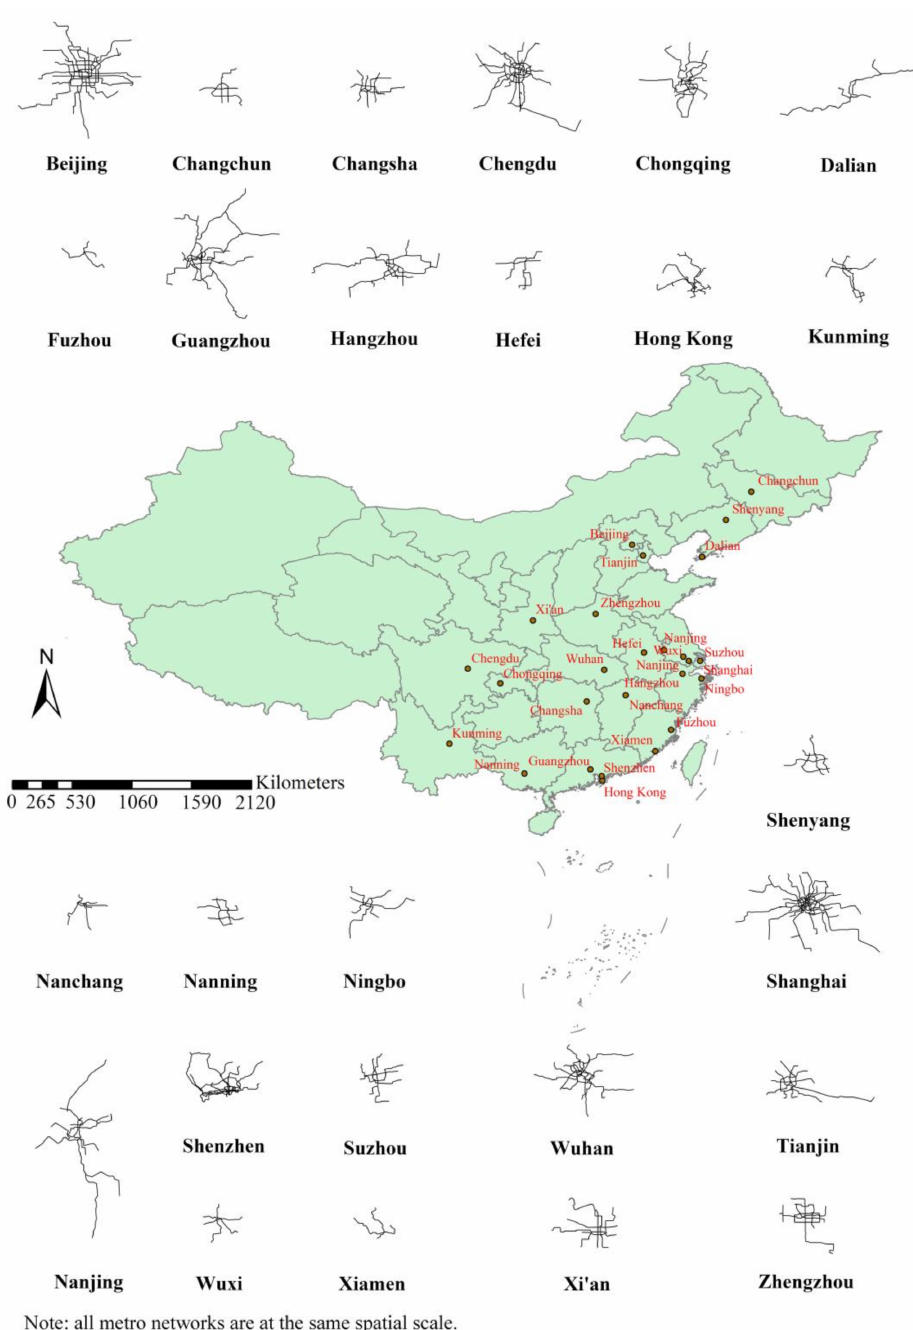
Figure 1. Metro networks of 26 cities in